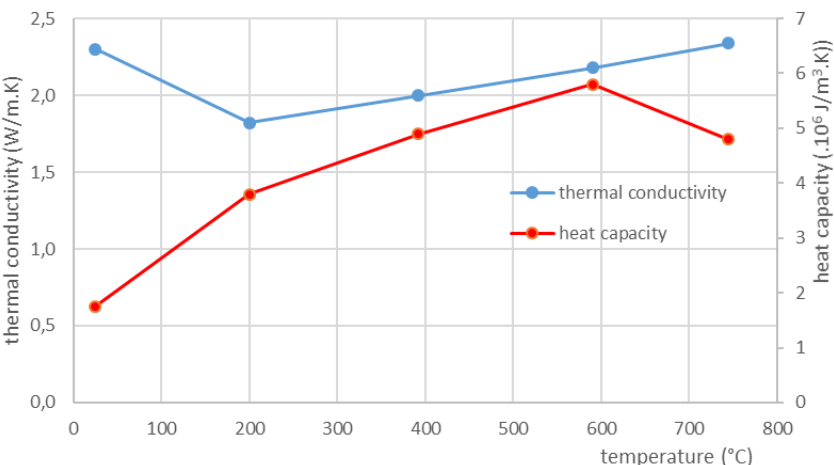
Figure 4. The course of the change in thermal conductivity [w/m · K] and volume heat capacity [J/m 3 · K] at the temperature for cementitious composite CC1 depending on ambient temperature [°C].